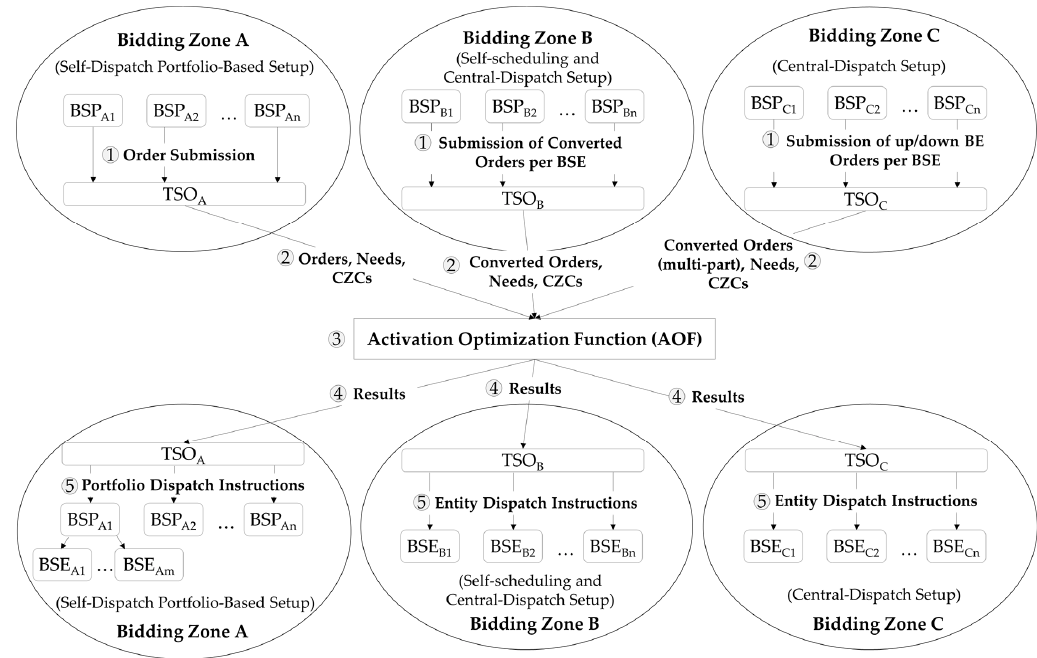
Figure 1. Replacement Reserves (RR) balancing process. Energies 2020 , 9 , x FOR PEER REVIEW